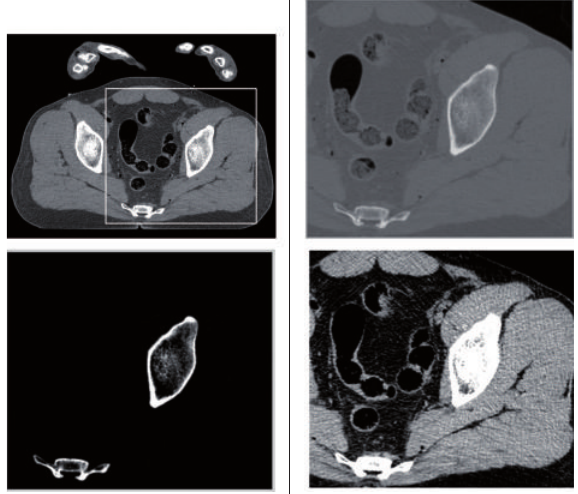
Figure 6: Left to right, upper to lower: test image with a marked zoom-in window, a zoom-in region depicted in dynamic ranges [−1000, 1500] , [100, 700] , [−100, 150] HU, respectively. Yet another version of this image appears in Figure 7 (upper left), in [−220, 350] HU.